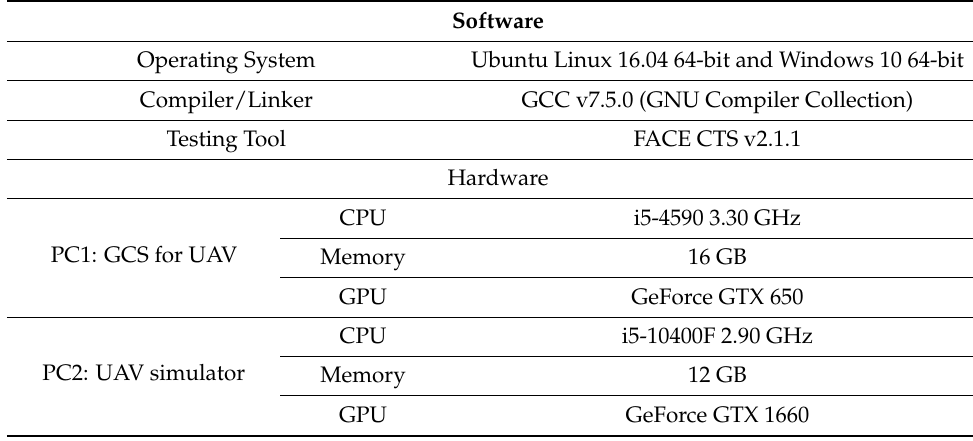
Table 6. Software and hardware environment of experiments.